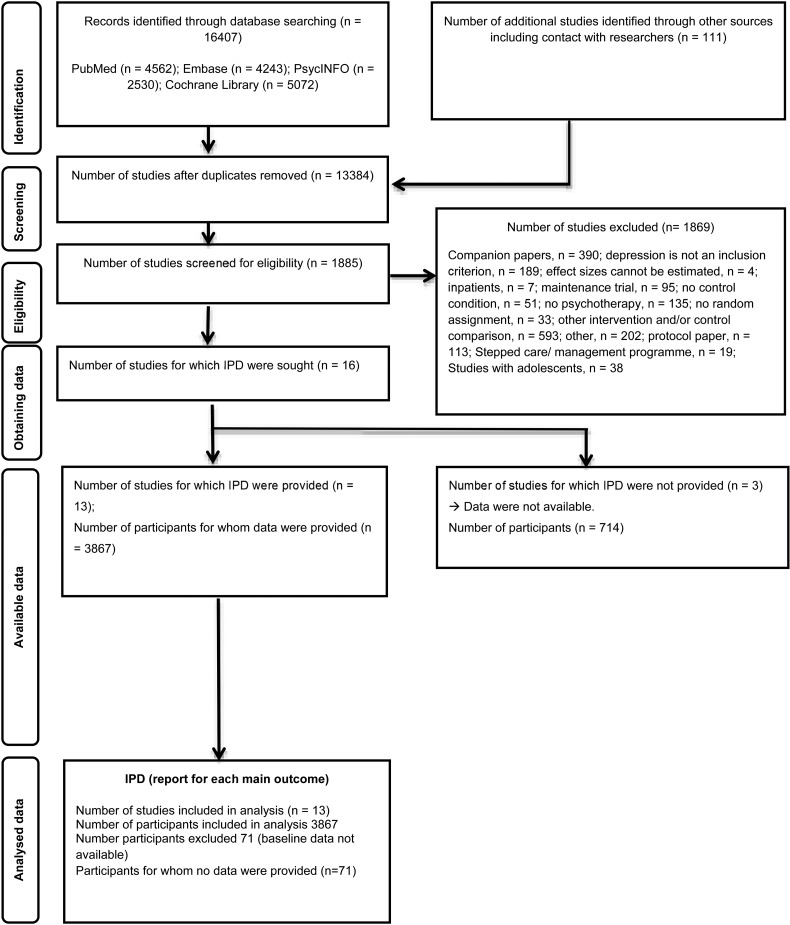
PRISMA IPD diagram of studies selection process.